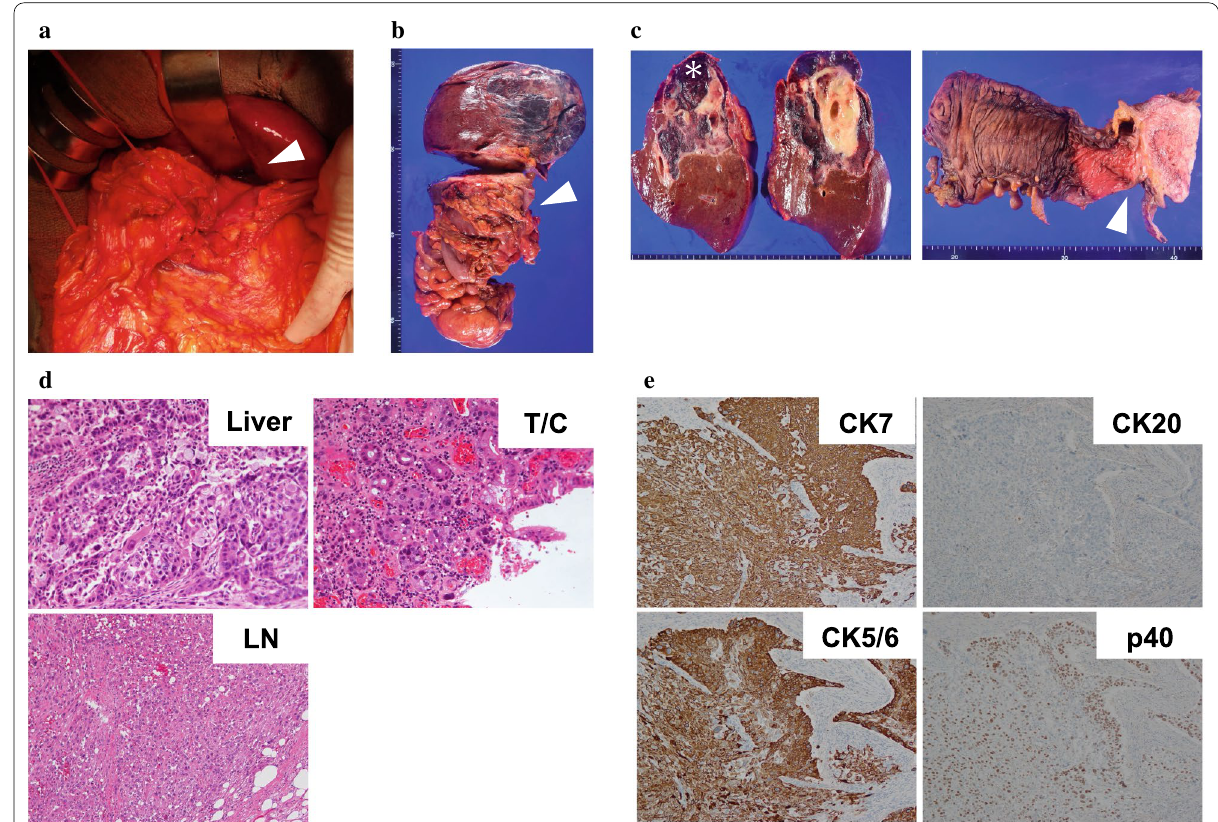
Fig. 2 Intraoperative and pathological findings. a Intraoperative photograph after laparotomy. The infiltrated site of the transverse colon was taped (arrowhead). b The surgical specimen showed infiltration of the transverse colon (arrowhead) by the tumor. c Macroscopic appearance of the sections of the liver (left) and the transverse colon (right) revealed that the tumor was solitary and whitish, 8.5 7.5 cm in × diameter, and had irregular margin. The dark-red lesion (*) was cavernous hemangioma. Direct invasion to the transverse colon was detected (arrowhead) d Hematoxylin–eosin staining of the tumor in the liver (Liver, 40), transverse colon (T/C, 40), and lymph node in the transverse × × mesocolon (LN, 20) revealed glandular structures and a tendency toward keratinization. Therefore, we concluded that the tumor included an × adenocarcinoma component as well as a squamous cell carcinoma component, suggesting ASC of the liver. e Immunostaining of the liver tumor revealed that the tumor was CK 7 ( ) and CK 20 ( ), indicating adenocarcinoma of the biliary system. The tumor was CK 5/6 ( ) and p 40 ( ), + − + + indicating that it also included a squamous cell carcinoma component ( ×